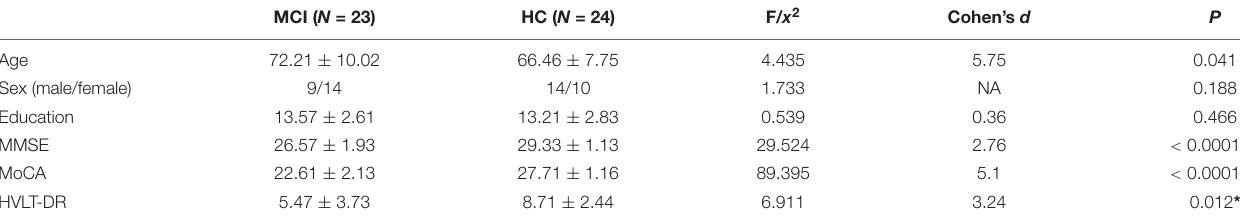
TABLE 1 | Demographics and cognitive performance of the elderly individuals without dementia grouped by MCI and NC.